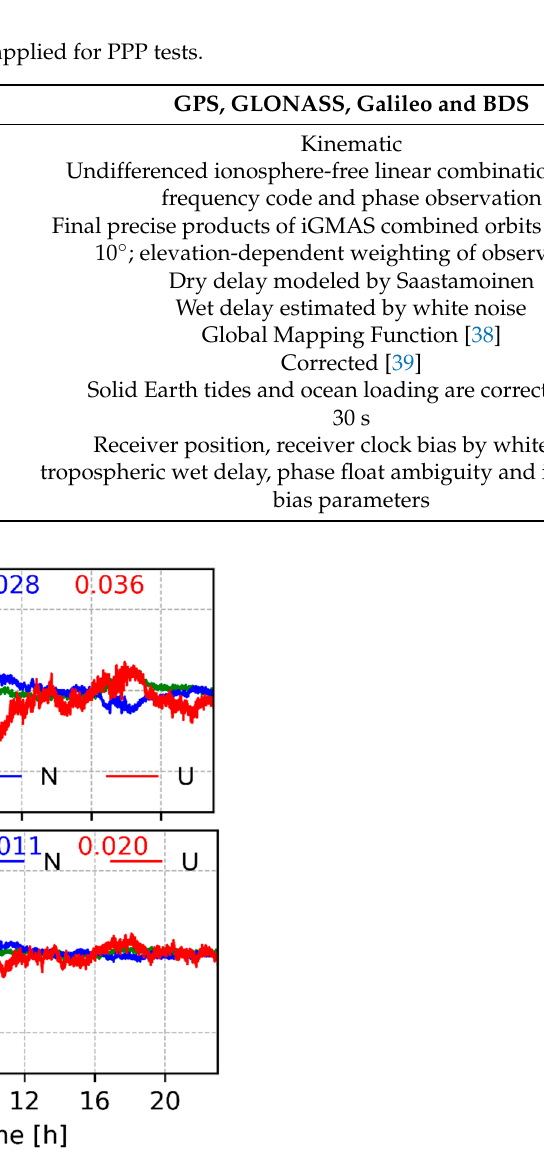
Figure 13. Positioning error of station JFNG in kinematic mode for GPS ( top panel ) and GPS/GLONASS/BDS/Galileo integrated ( bottom panel ) PPP. Table 3. Statistics of PPP accuracy using iGMAS combined orbit and clock, unit: cm.